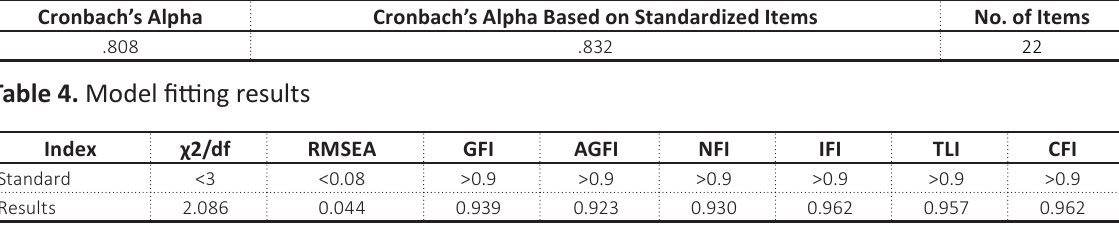
Figure 1 is the CFA diagram; the paper conducts